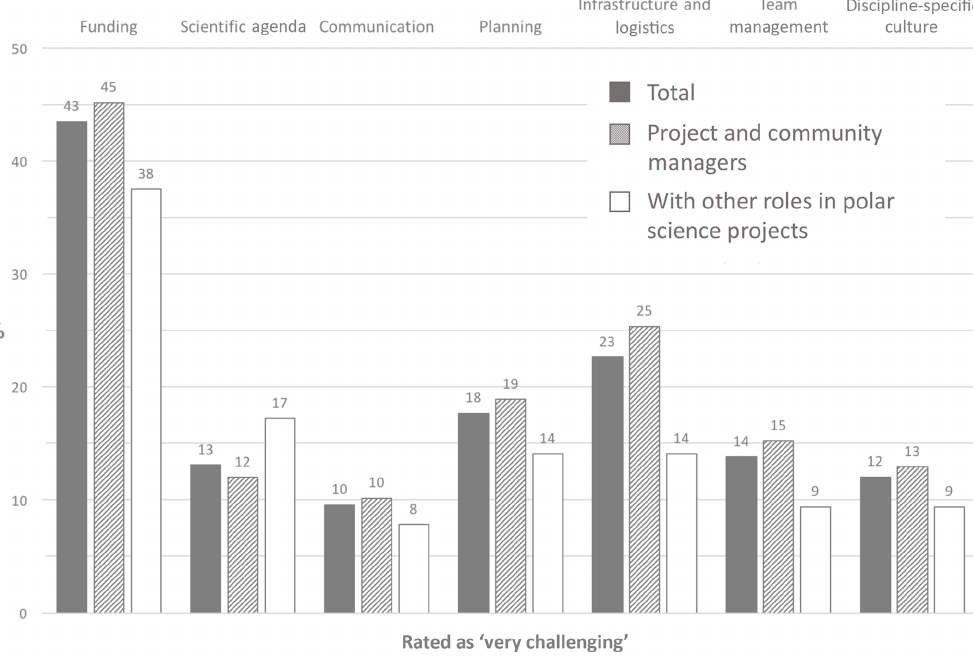
Figure 7. Challenges associated with interdisciplinary work in polar science projects. Survey respondents (%) rating as “5 – very challenging” when asked the question Q11: Interdisciplinary nature of polar sciences: Please rate (from 1 to 5) the following